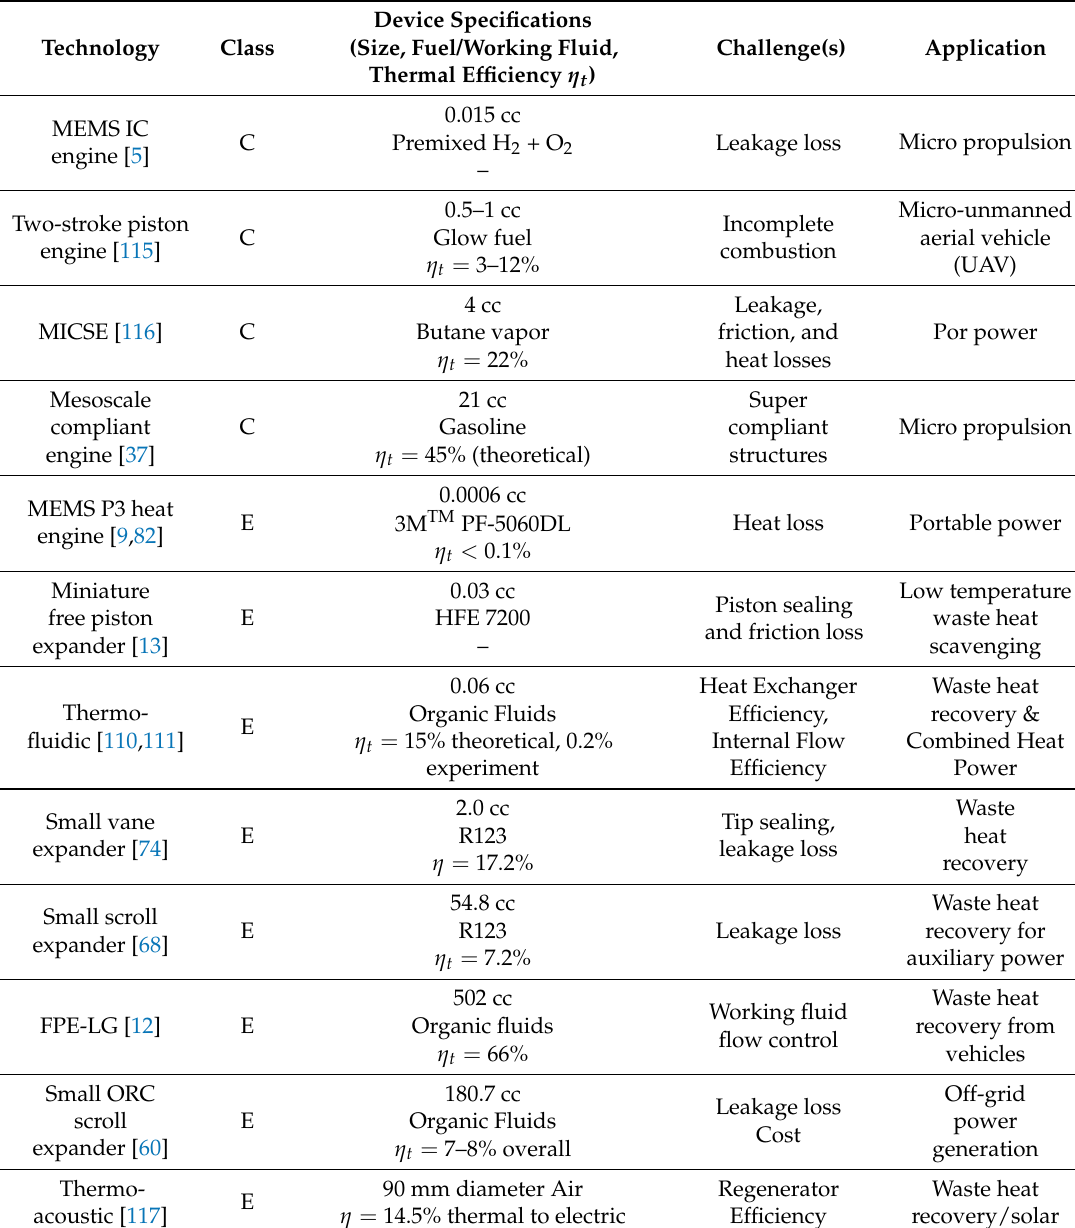
Table 1. Summary of different power generation technologies over a wide range of sizes (0.006–500 cc). Note the technology classification: combustion-based (C) and External heat